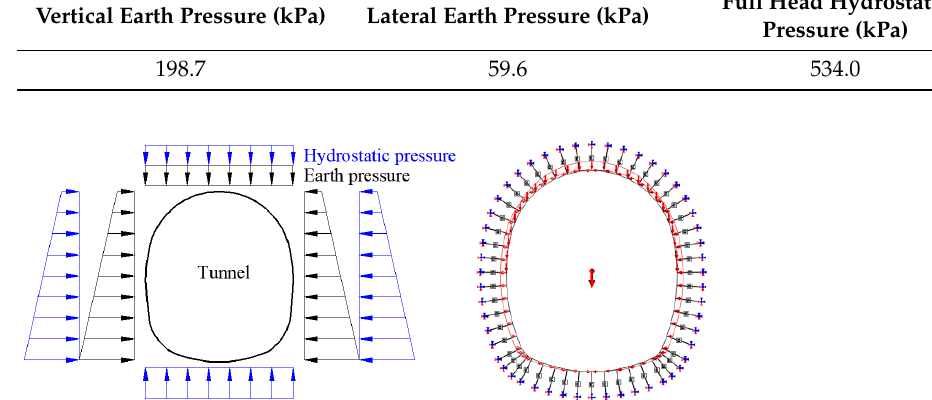
Figure 8. The calculation model. Table 8. The load calculation. Vertical Earth Pressure (kPa) Lateral Earth Pressure (kPa)